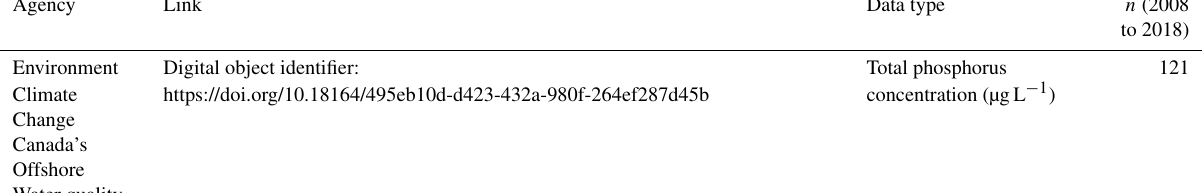
Table A1. The data sources for total phosphorus concentrations and surface currents were all retrieved from publicly available online repos-